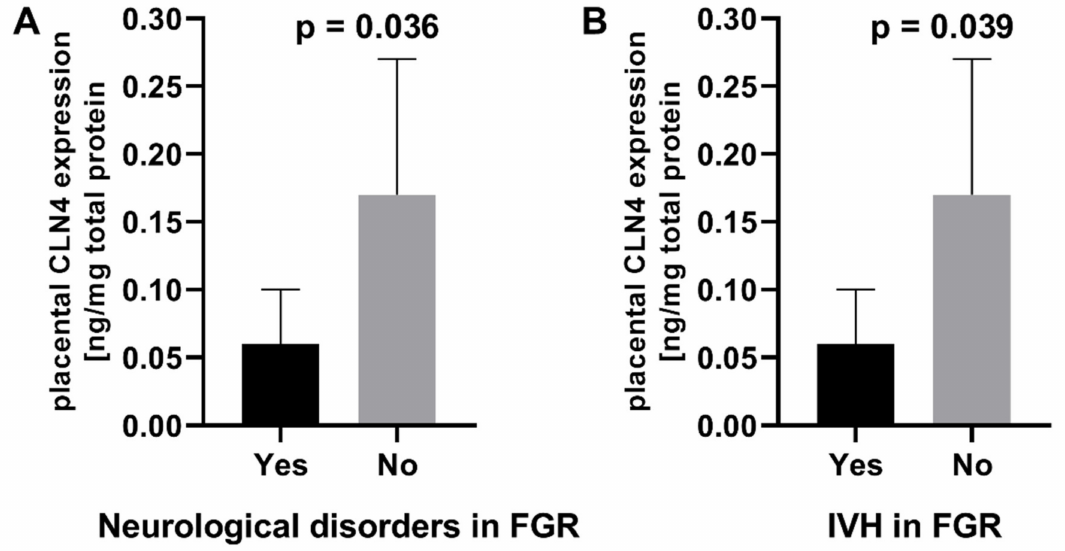
Figure 2. ( A ) Comparison of placental CLN4 expression with reference to neurological disorders in fetal growth restriction (FGR) and ( B ) intraventricular hemorrhage (IVH) in FGR newborns. The serum NME1 levels showed a prognostic value for IVH in the FGR group (cut-off value for NME1: 40.45 pg/mL; sensitivity: 0.71; specificity: 0.76; PPV: 0.21; NPV: 0.97; LR+: 2.93; LR-: 0.38; ACC: 0.753; AUC: 0.745; p = 0.0315). The placental CLN4 expression was useful in the prediction of newborn IVH (cut-off value for CLN4: 20.82 ng/mg total protein; sensitivity: 1.00; specificity: 0.83; AUC: 0.879; p <